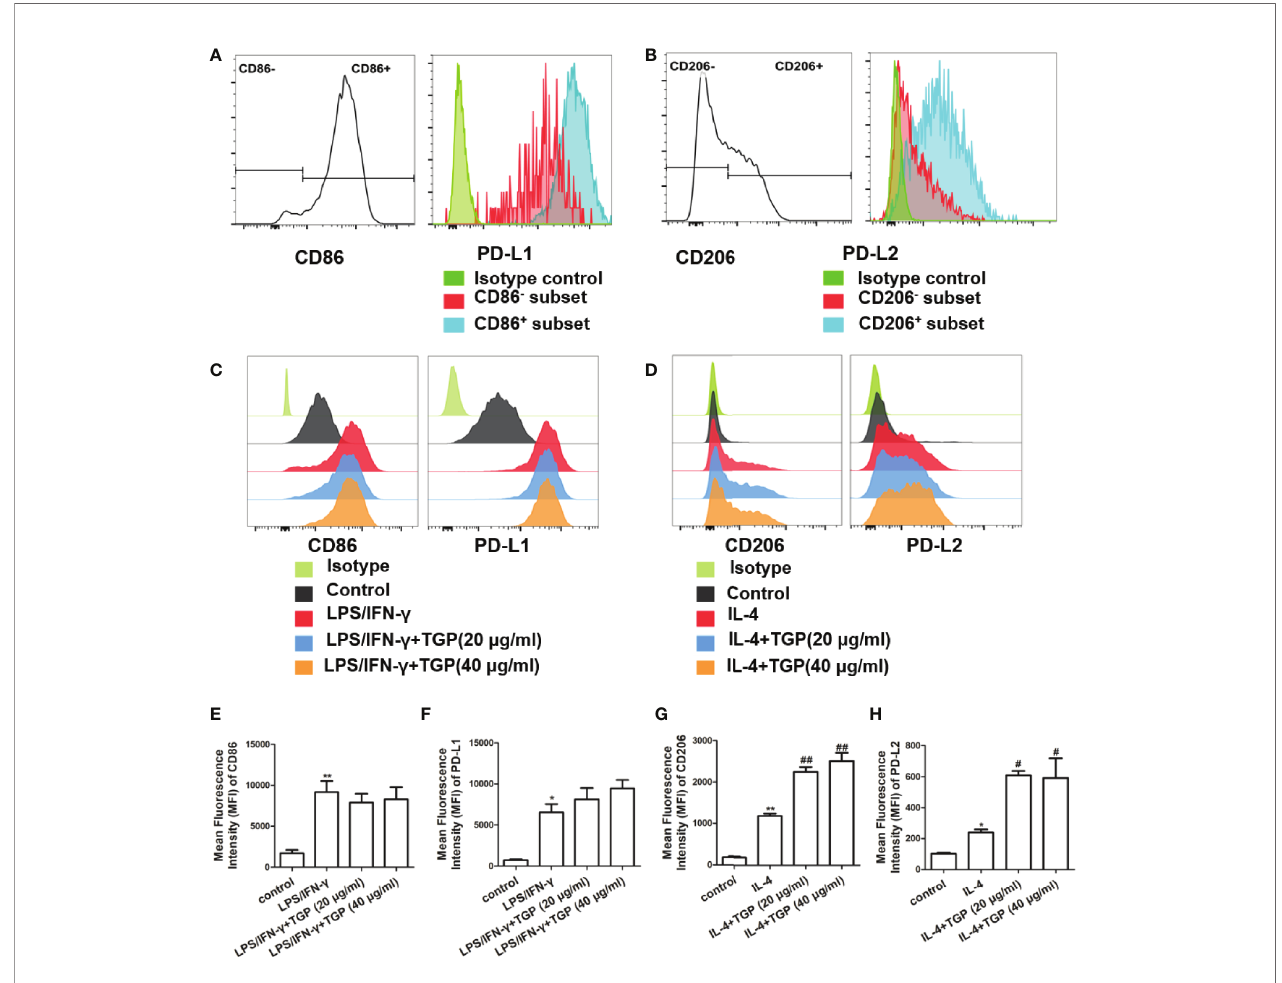
FIGURE 5 | TGP promotes PD-Ls-expressing macrophage polarization in vitro . (A) Representative FACS plots show the expression of PD-L1 in CD86 - and CD86 + Raw264.7 macrophages stimulated with LPS/IFN- g . (B) Representative FACS plots display the expression of PD-L2 in CD206 - and CD206 + Raw264.7 macrophages stimulated with IL-4. (C) The expression of CD86 or PD-L1 in LPS/IFN- g -treated Raw264.7 cells was determined via FACS. (D) The expression of CD206 or PD-L2 in IL-4-treated Raw264.7 cells was determined via FACS. (E – H) Data are shown as the mean percentages of CD86 (E) and PD-L1 (F) expression in LPS/IFN- g -treated Raw264.7 cells or CD206 (G) and PD-L2 (H) expression in IL-4-treated Raw264.7 cells. Data are presented as means ± SD (n=3-4, **p<0.01 or *p < 0.05 compared with control, and ## p < 0.01 or # p < 0.05 compared with LPS/IF- g or IL-4 group without